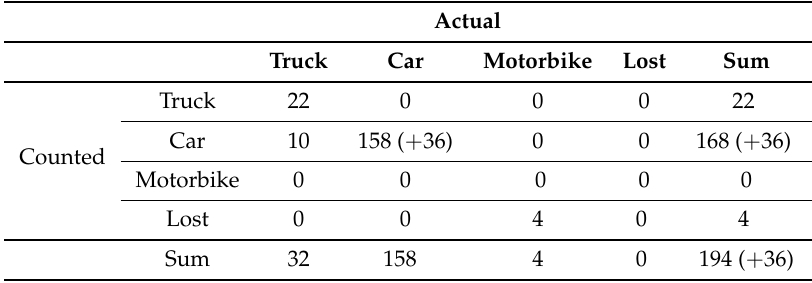
Table 9. Counting results per vehicle type from a highway with 1000 ms request interval. There are more vehicles counted then available.